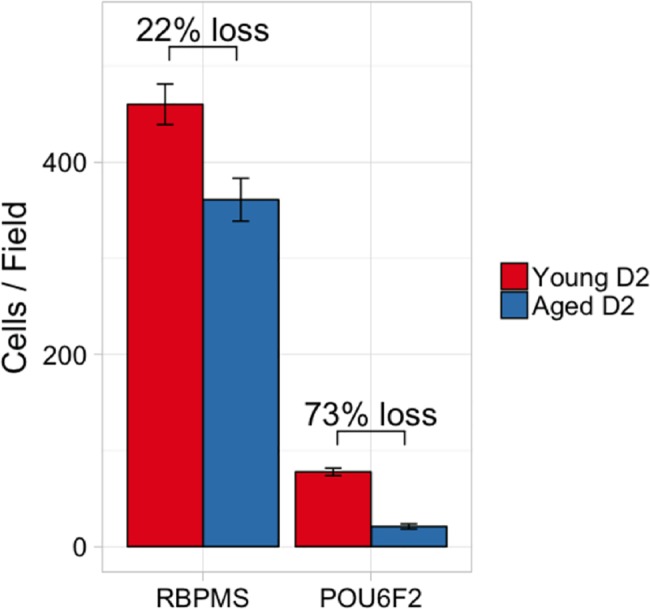
The selective sensitivity of POU6F2 RGC subtypes is demonstrated using the DBA/2J model of glaucoma.There was a 22% loss of RBPMS-labeled RGCs in aged DBA/2J mice (8 months of age, Aged D2) as compared to young DBA/2J mice (2 months of age, Young D2). There was a dramatic loss of 73% of the POU6F2-positive cells comparing the Young D2 mice to the Aged D2 mice. These data demonstrate the sensitivity of the POU6F2 RGC subtype to glaucoma.